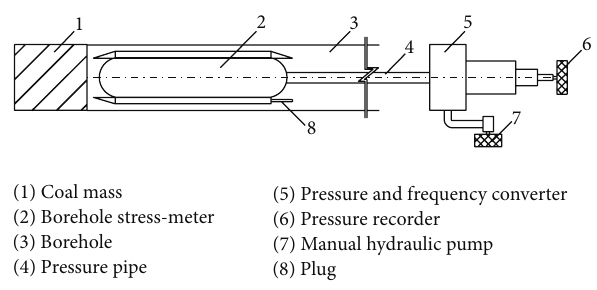
Figure 2: Installation drawing for the borehole